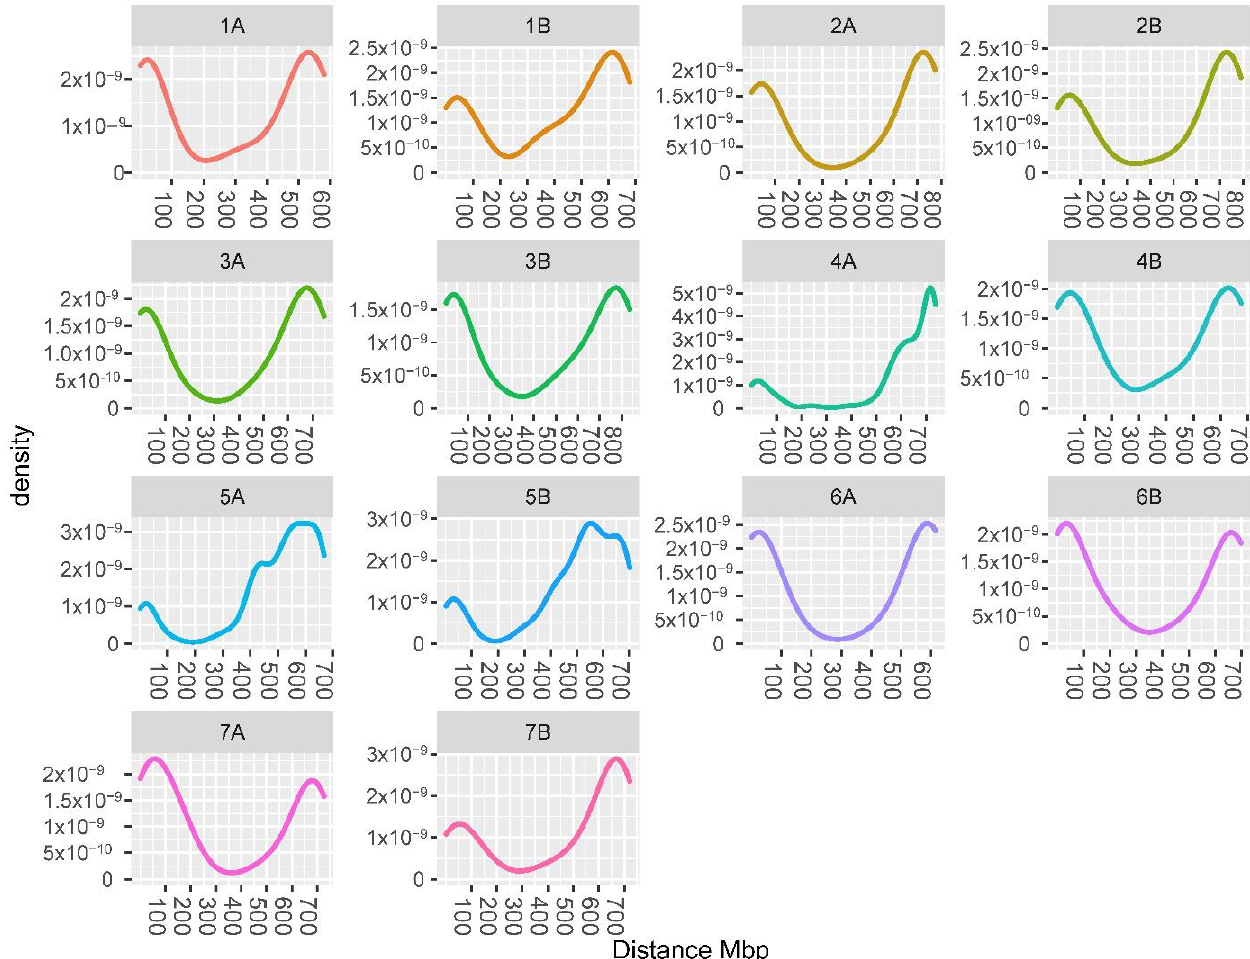
Figure 1. The linkage disequilibrium decay for the genotypic panel is 2 Mbp [32].